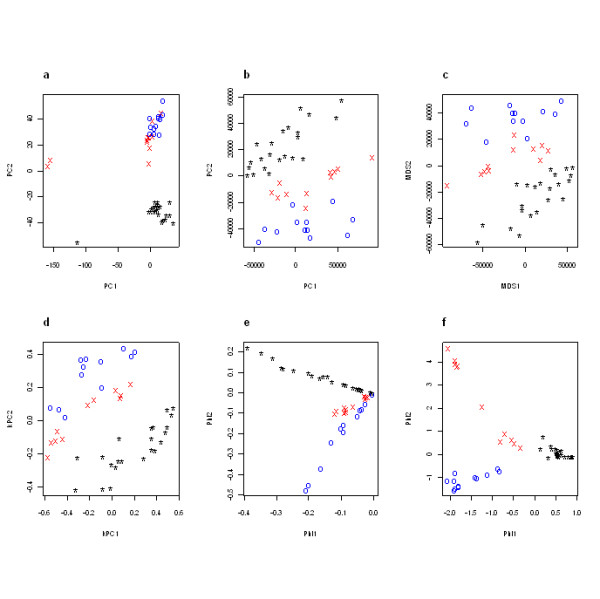
Two-dimensional projections of the Affymetrix primary fibroblast cell lines, using six DR methods. For each plot, red 'x' symbols denote samples from bonobo (Pan paniscus), blue 'o' symbols denote samples from gorilla (Gorilla gorilla), and black '*' symbols denote samples from human (Homo sapien). (a) Two-dimensional projection calculated with PCA-correlation. (b) Two-dimensional projection calculated with PCA-covariance. (c) Two-dimensional projection calculated with nonmetric MDS. (d) Two-dimensional projection calculated with kernel PCA. Epsilon parameter was selected at optimal classification using QDA (ε = 67,000). (e) Two-dimensional projection calculated with the spectral method from Ng et al. Epsilon parameter was selected at optimal classification using QDA (ε = 20,000). (f) Two-dimensional projection calculated with the spectral method from Lafon.